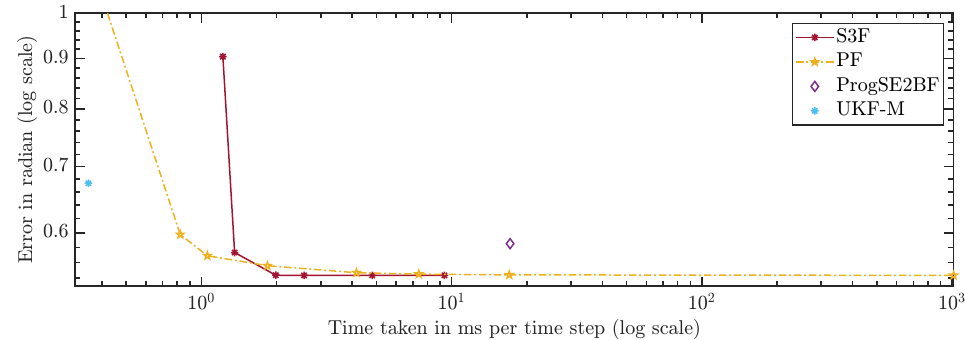
Figure 14. Orientation error over run